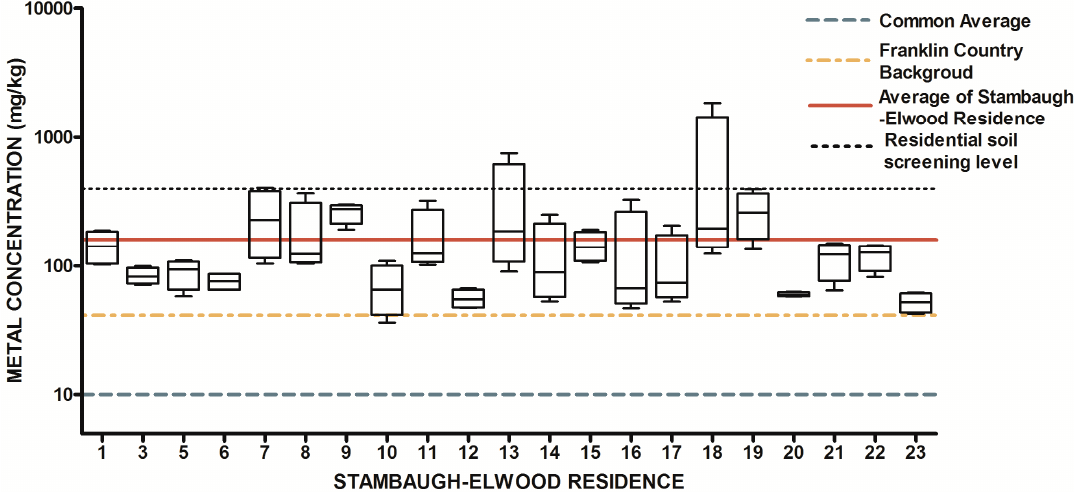
Figure 9. Residential urban soil level of Pb in the Stambaugh-Elwood community versus Franklin County (background), common averages and residential screening levels (RSLs) (mg/kg soil). Soil samples were taken from 21 of 46 residences that consented for the study in compliance with OSU IRB Protocol 2014B0445-exempt. Each sample consisted of four subsamples. Analysis